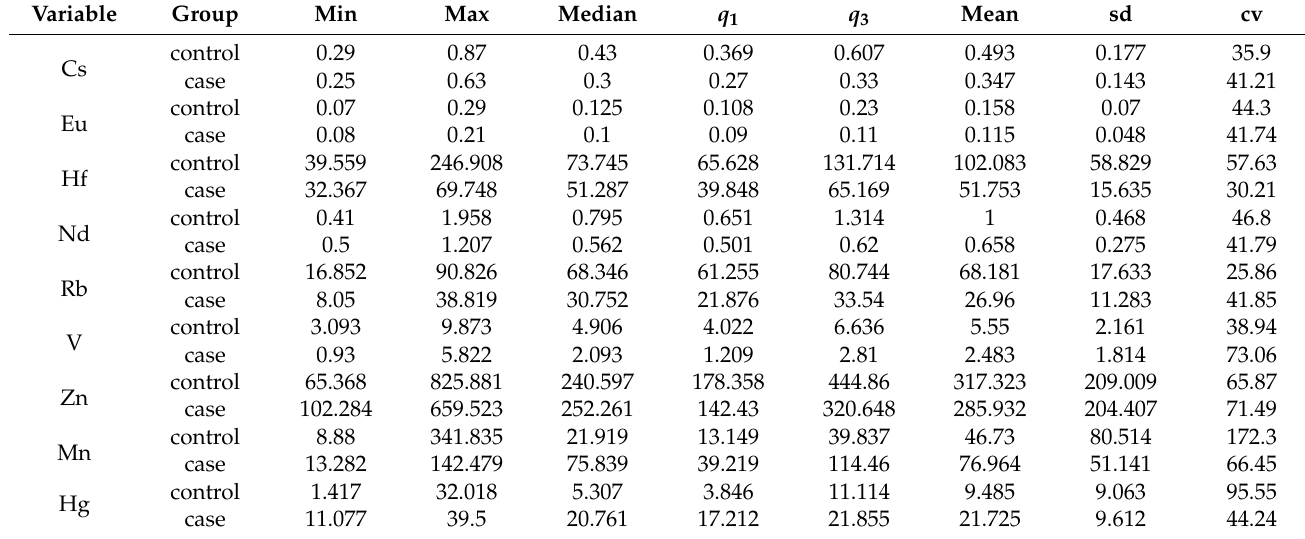
Table 1. Descriptive statistics of the studied groups of patients undergoing cataract surgery: the case group of HD patients undergoing hemodialysis ( n = 6) and the control group of patients without hemodialysis ( n = 16). Elemental mean concentrations expressed in µg L − 1 are presented, together with spread measurements such as the variance coefficient (cv), standard deviation (sd), the first quartile ( q 1 ), and the third quartile ( q 3 ).